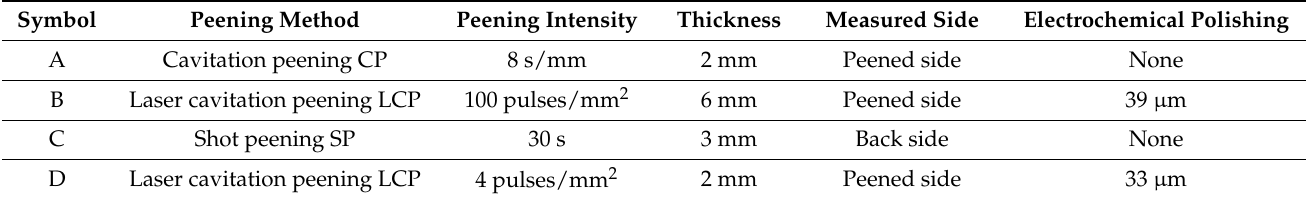
Table 1. Specimens for residual stress